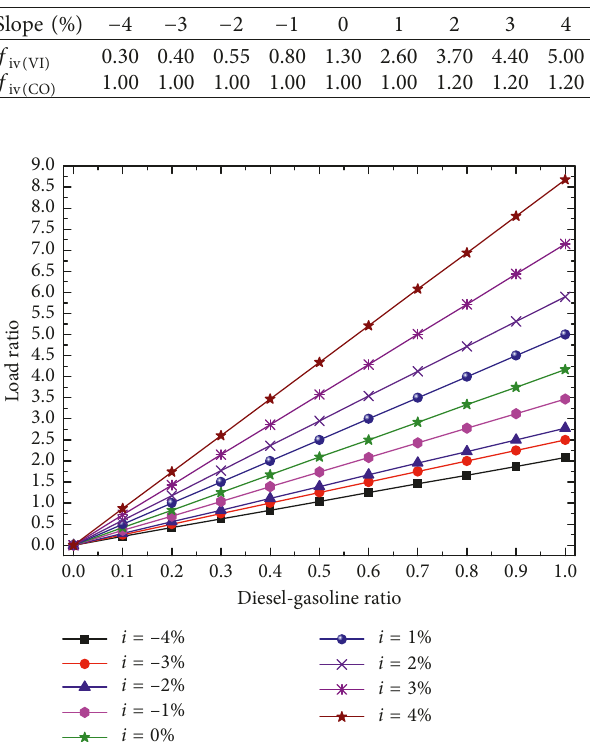
Figure 3: Load ratios changing with slope percentage (10km/h, jamming condition).